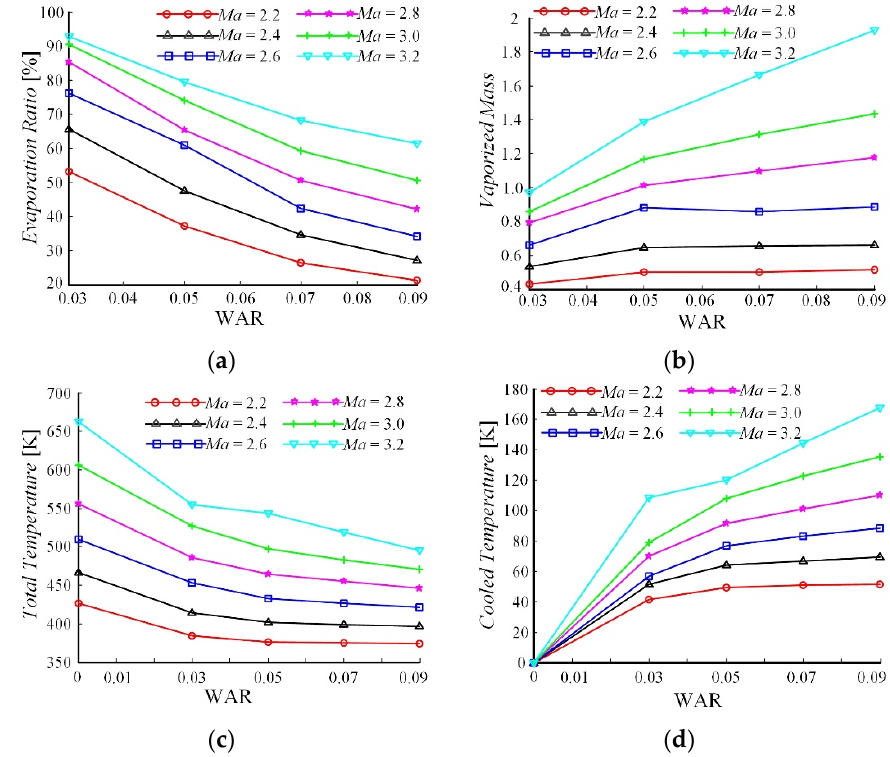
Figure 16. Distribution of evaporation and temperature with respect to WAR and Mach number ( a ) evaporation ratio, ( b ) vaporized mass, ( c ) total temperature, ( d ) cooled total temperature.